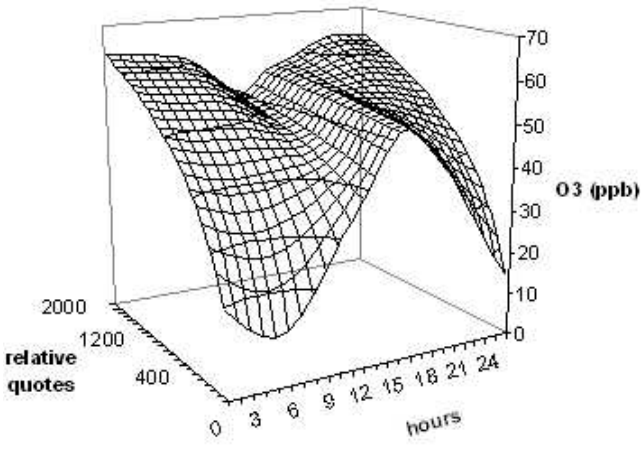
FIGURE 2. Ozone concentration dependence on altitude and daytime (Loibl